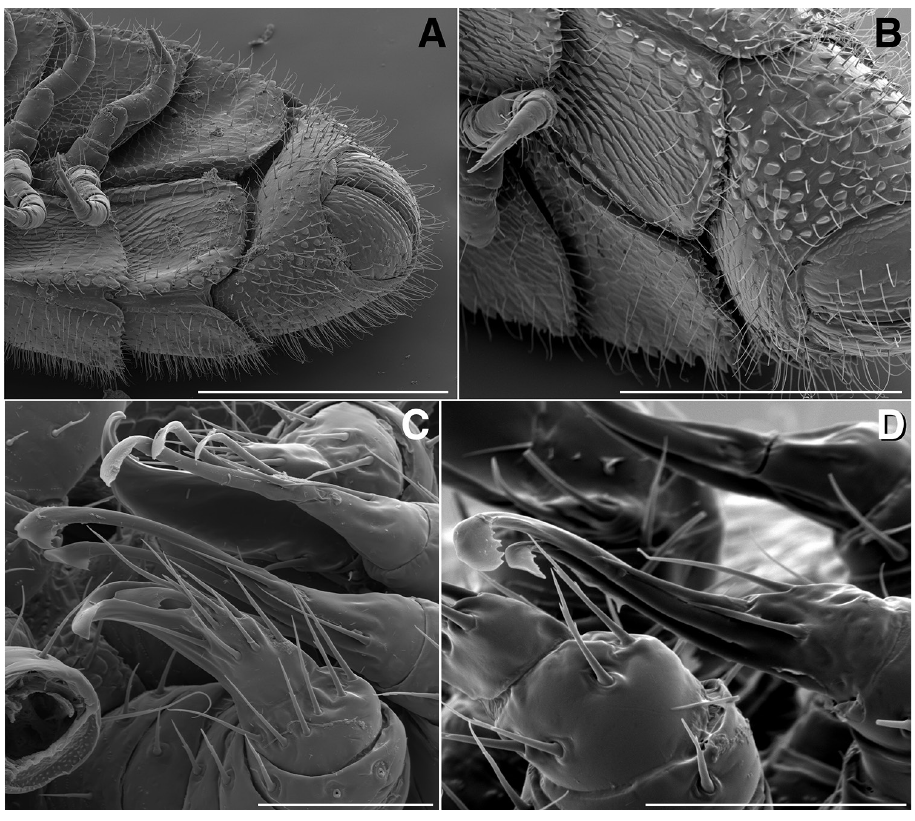
Figure 11. A Ventrolateral view of apodous ring, telson, hypoproct and paraprocts of I. tobini sp. n. (scale bar 300 µm) B the same of I. plenipes (scale bar 200 µm) C Lateral (right) view of gonopods—cen- tered on right posterior gonopod—of I. tobini sp. n. (scale bar 50 µm) D the same of I. plenipes (scale bar 50 µm). (Catalog #s: I. tobini sp. n. MPE00735, I. plenipes